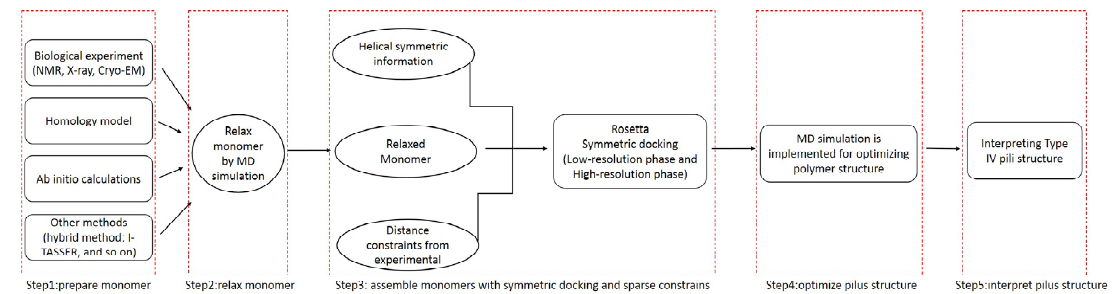
Figure 8. Workflow for Type IV pilus structure modeling and interpretation.